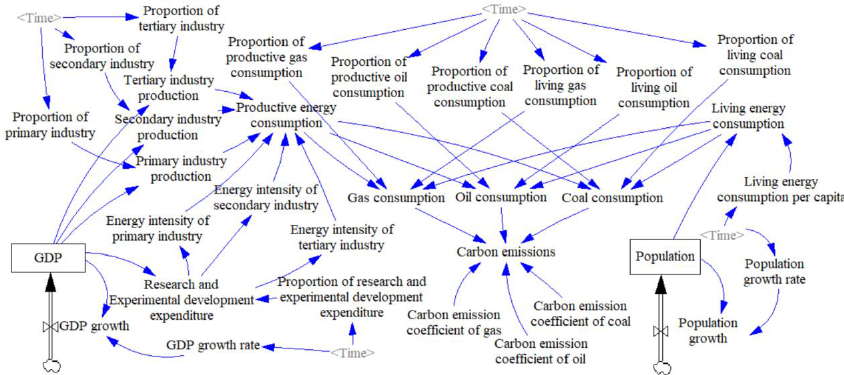
Figure 2. China’s carbon emission system: stock -flow diagram.